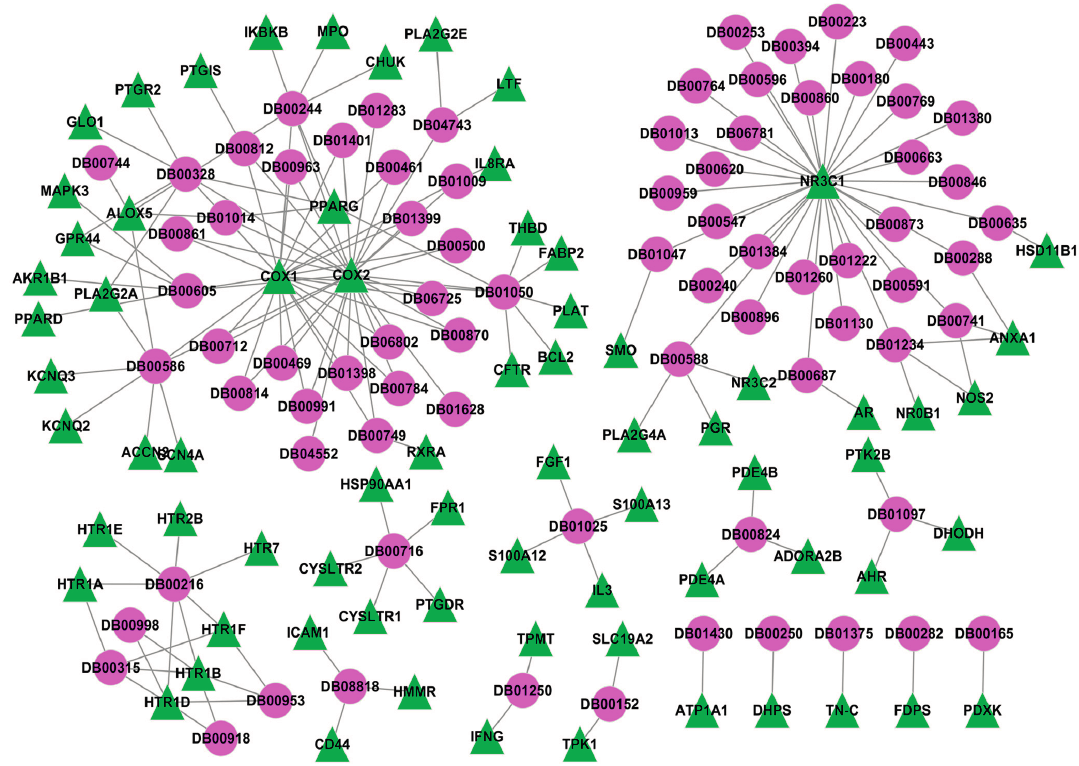
Figure 2. The D–T network where fuchsia circular nodes represent the DrugBank ID of anti-inflammatory drugs and lime diamond nodes represent the therapeutic targets,